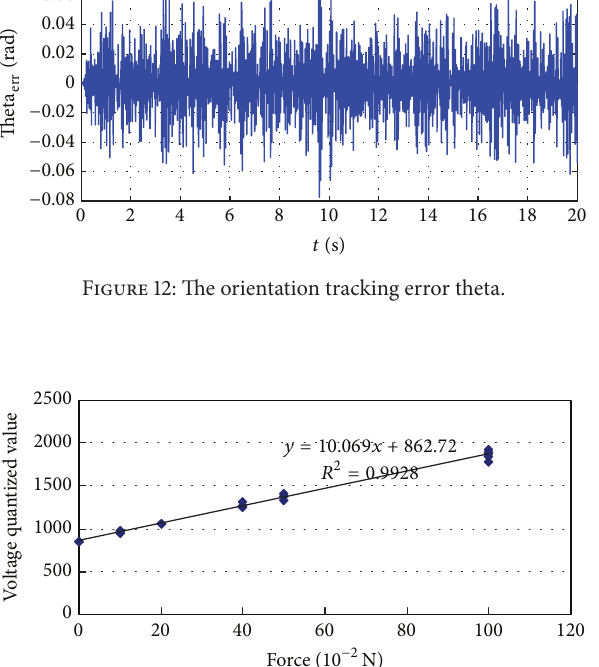
Figure 11: The orientation tracking error phi.